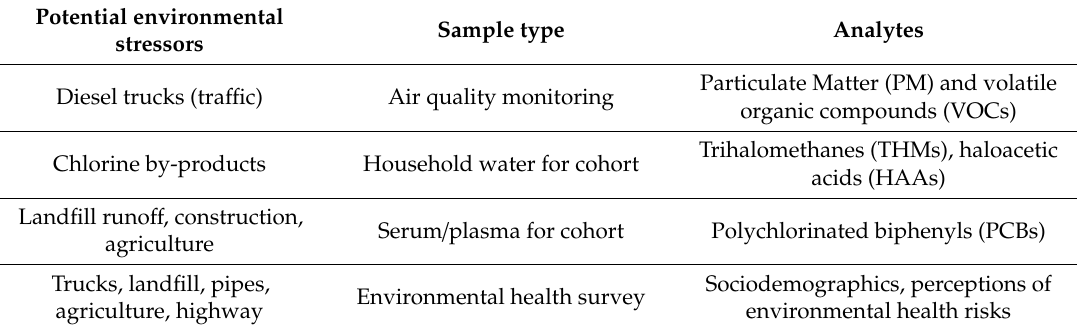
Table 2. Potential environmental stressors, sample type, and analytes of the case